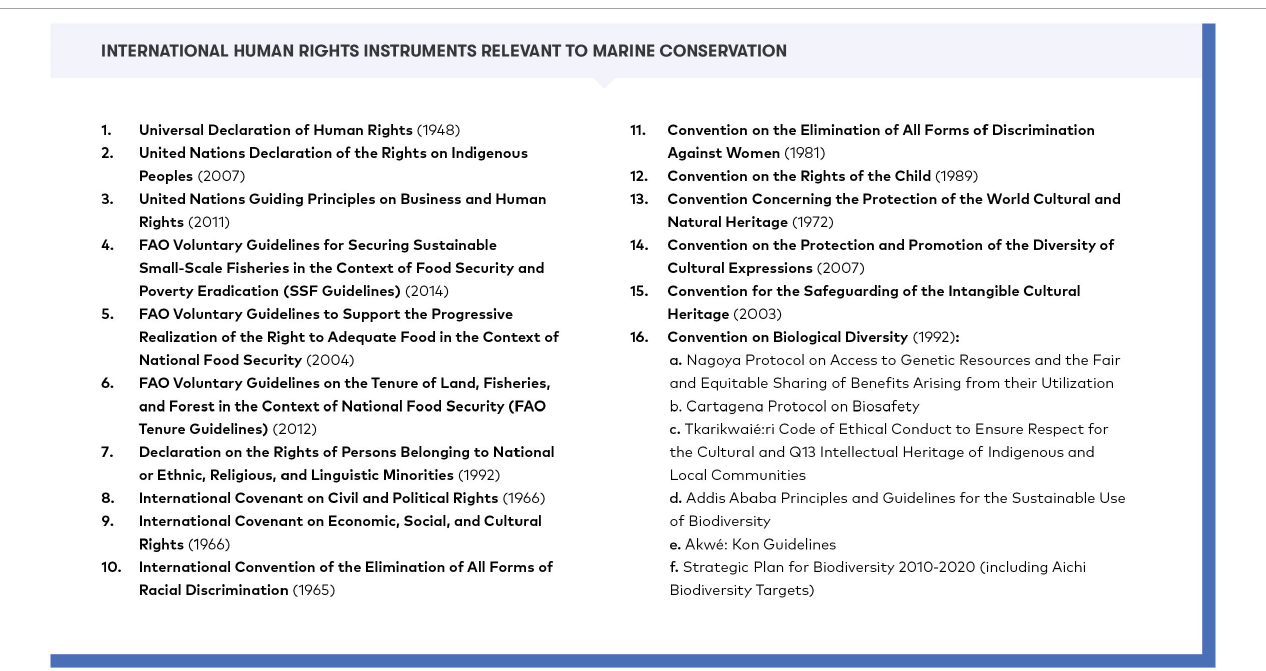
TABLE 2 Key international instruments with human rights implications for marine conservation.